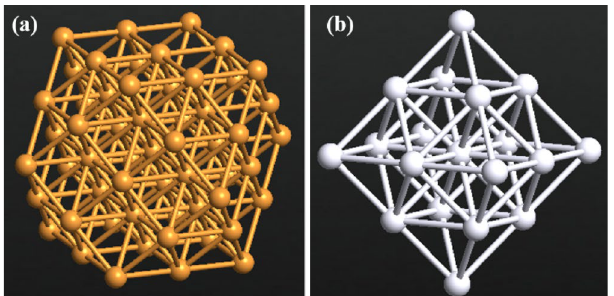
Figure 3. The added MNPs with 5 Å radii ( a ) copper ( b ) silver. Produced by QuantumATK software (version